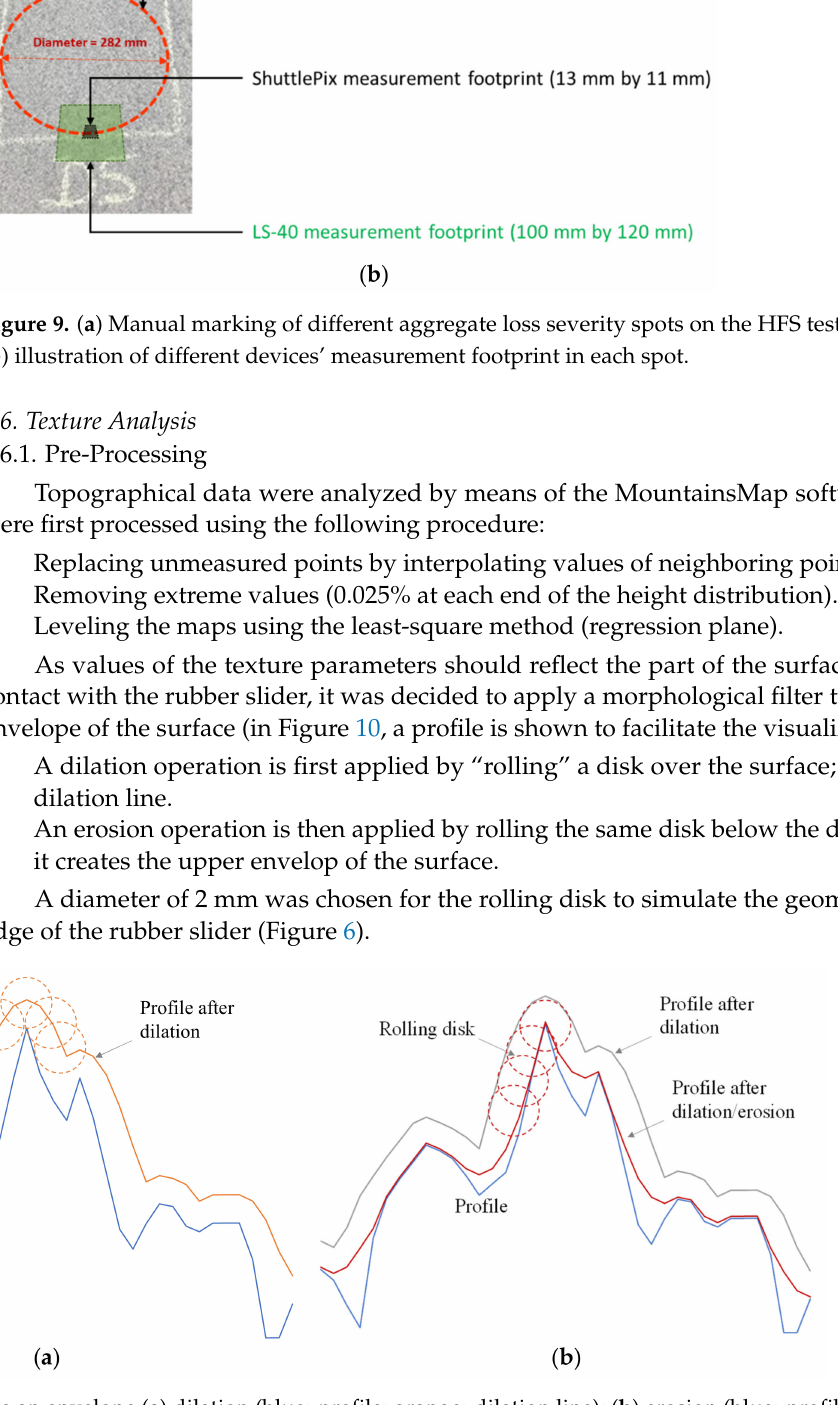
Figure 10. Operations to create an envelope ( a ) dilation (blue: profile; orange: dilation line); ( b ) erosion (blue: profile; grey: dilation line; red: